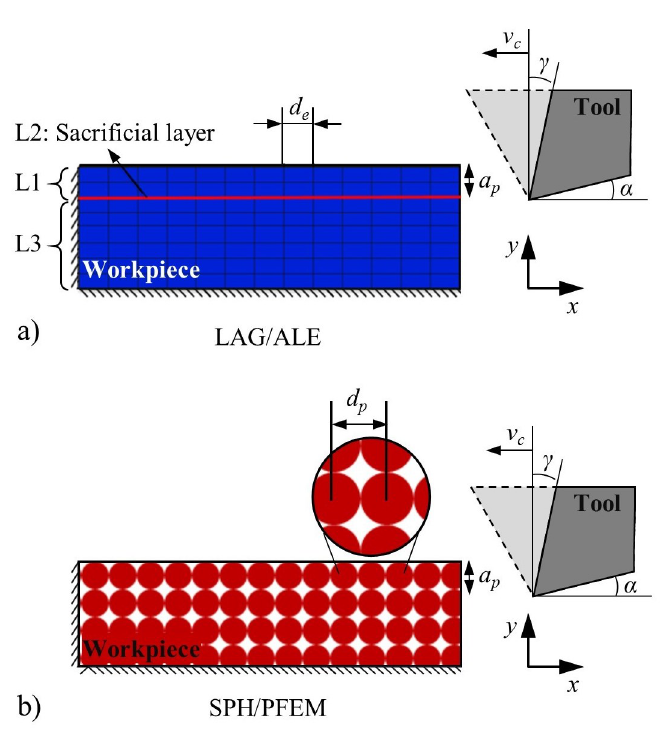
Figure 6. 2D Simulation framework of the LAG/ALE models ( a ) and SPH/PFEM models ( b ).